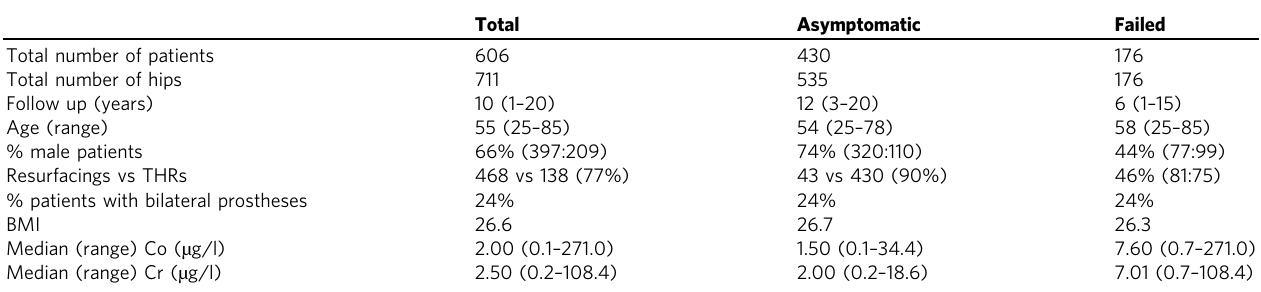
Table 1 Clinical details of all the patients from all centres in the study, divided by clinical